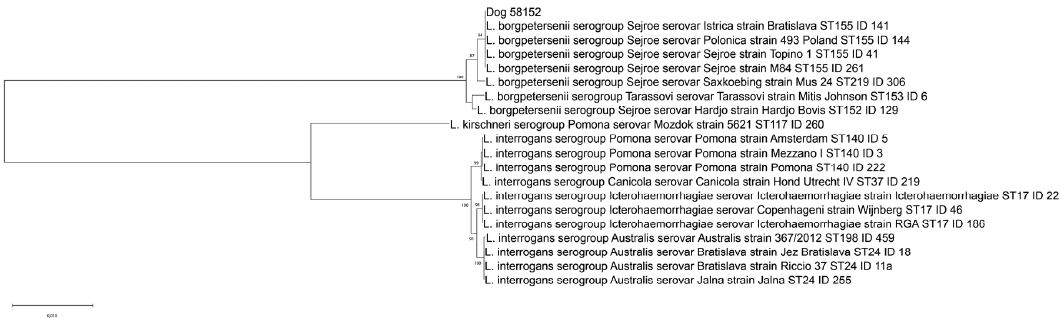
Figure 1. Phylogenetic tree built on concatenated sequences of the seven multi-locus sequence typing (MLST) loci (3111 bp) of the scheme proposed by Boonsilp and colleagues [17]. Phylogeny was conducted in MEGA 11 using the Neighbor-Joining method and bootstrap values are indicated on the respective branches. The samples are indicated with their ID, which represents a unique identification number of the relative reference strain present in the collection of the Italian Reference Centre for Animal Leptospirosis (IZSLER, Brescia,